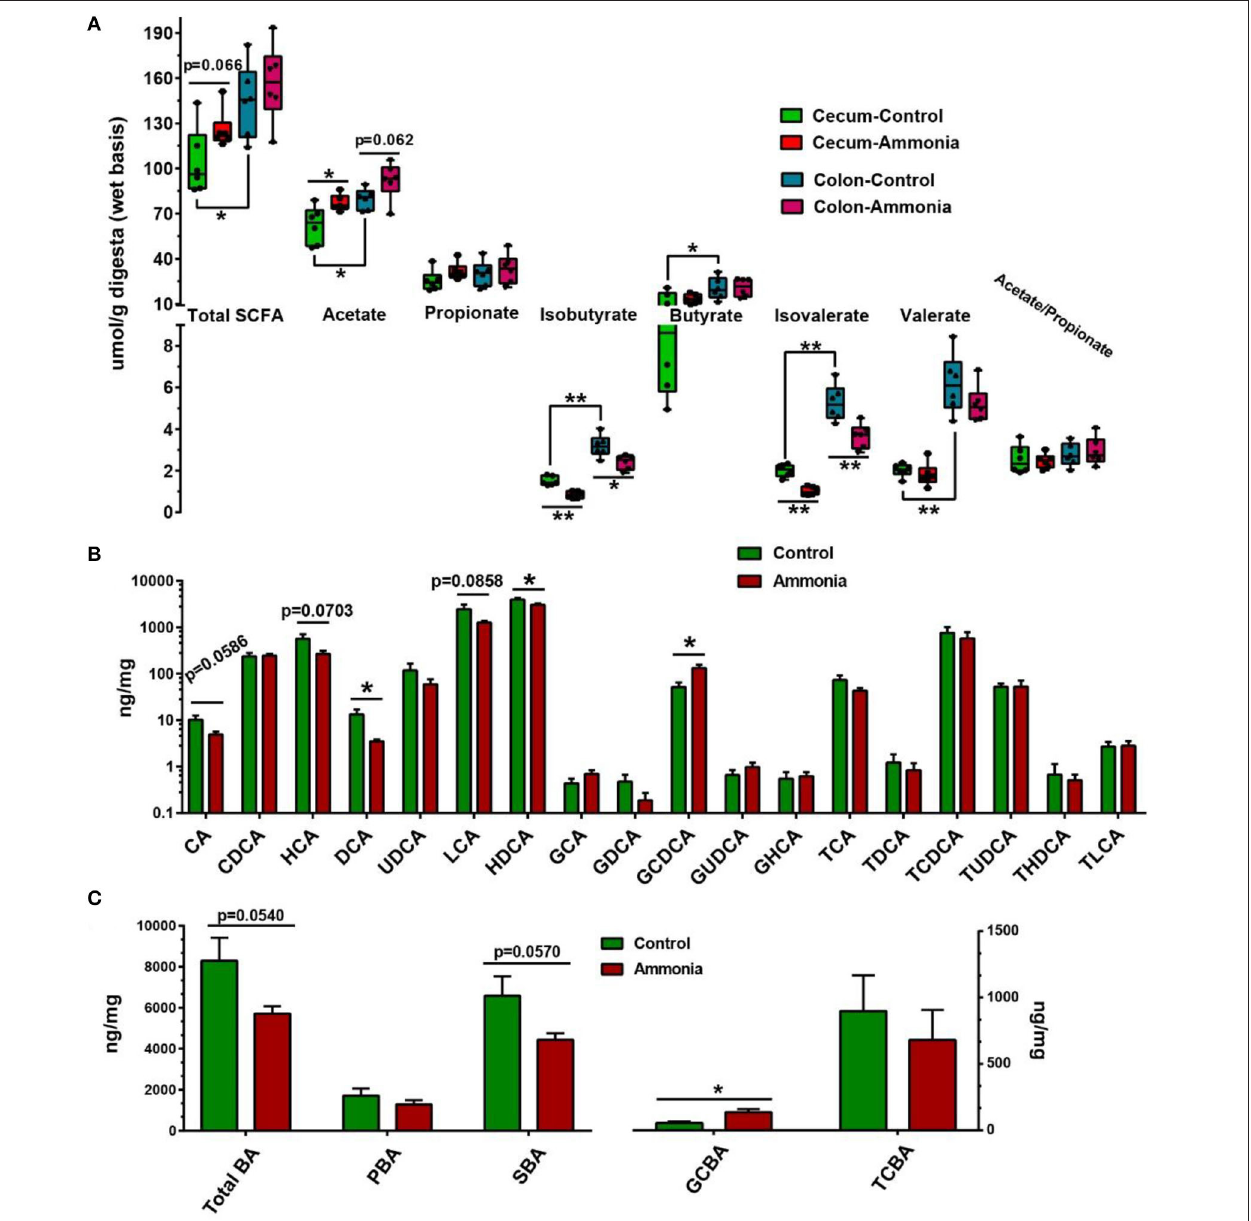
FIGURE 5 | SCFA and BA production from the cecum or colon digesta in pigs exposed to ammonia or not. (A) Changes in the SCFA profile of the cecum or colon after ammonia exposure; (B) changes in each BA content; and (C) each type of BA content in the cecum of pigs exposed to high ammonia. Data are expressed as min to max showing all points or mean ± SE ( n = 6), * p < 0.05 and ** p <